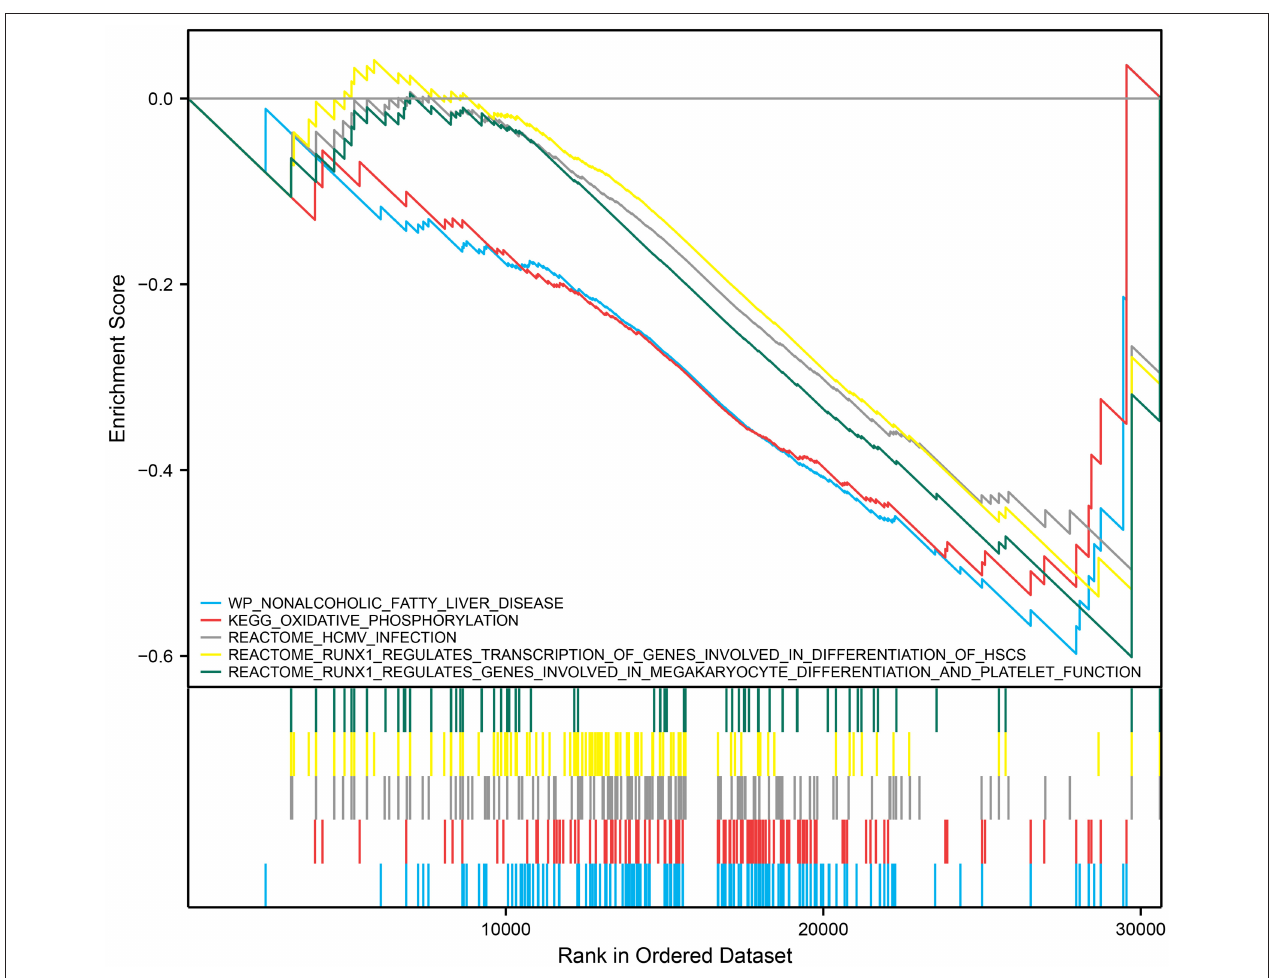
FIGURE 7 | RUNX1 GSEA at the bulk RNA